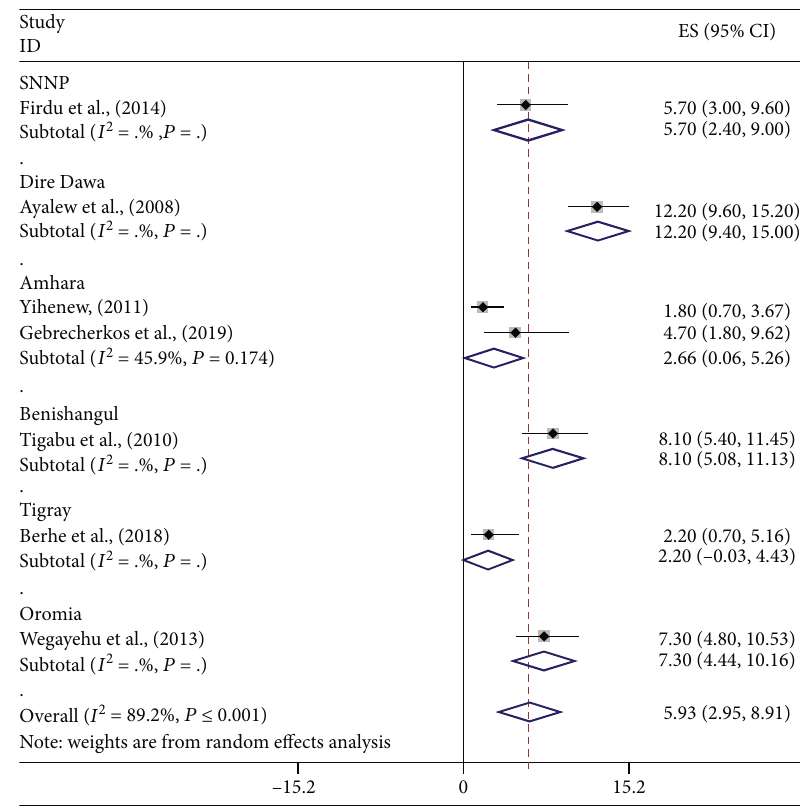
Figure 5: The pooled prevalence of Cryptosporidium spp. among study subjects in Ethiopia.